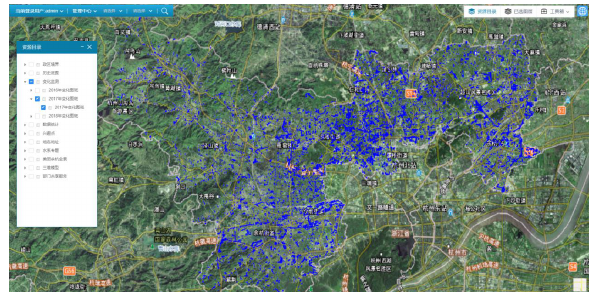
Fig.8 Unban Space Change Monitoring Result for Yuhang